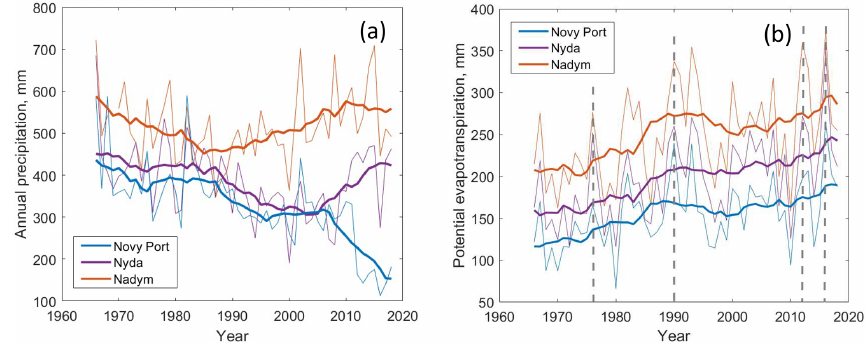
Figure 5. (a) Time series of annual precipitation and (b) potential evapotranspiration. Thick curves correspond to 10-year running average. Dashed lines in panel (b) mark the years of major fires.